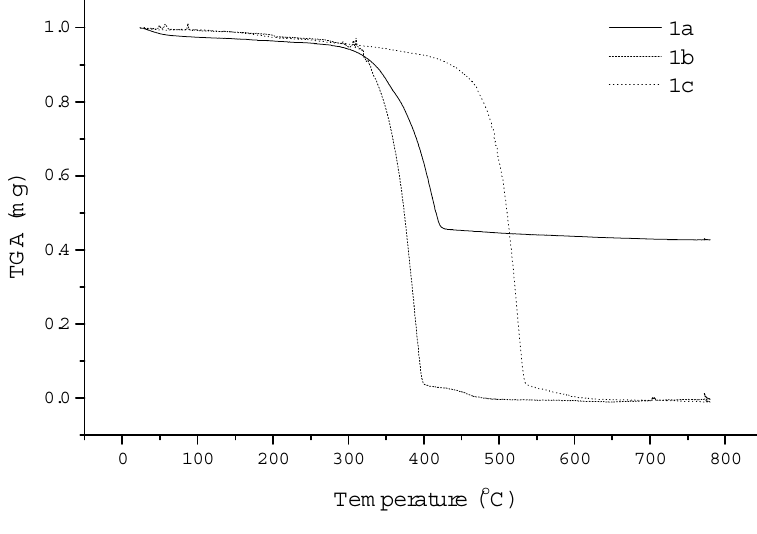
Fig. 2 The normalized TGA curves of 1a-c